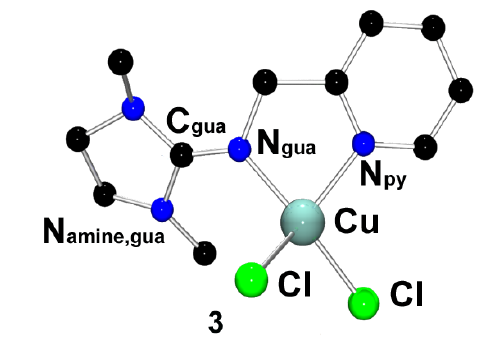
] ( 3 ) in the solid state. 2